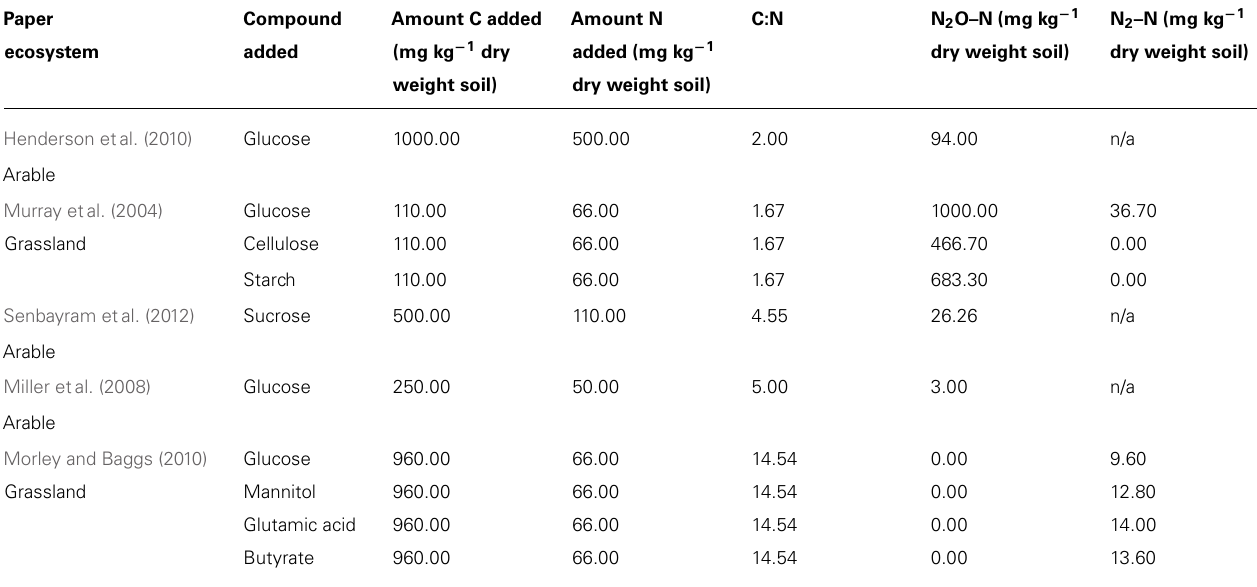
Table 1 | Studies measuring the effects of low molecular weight carbon compounds on the production of N 2 O from soils. Paper ecosystem